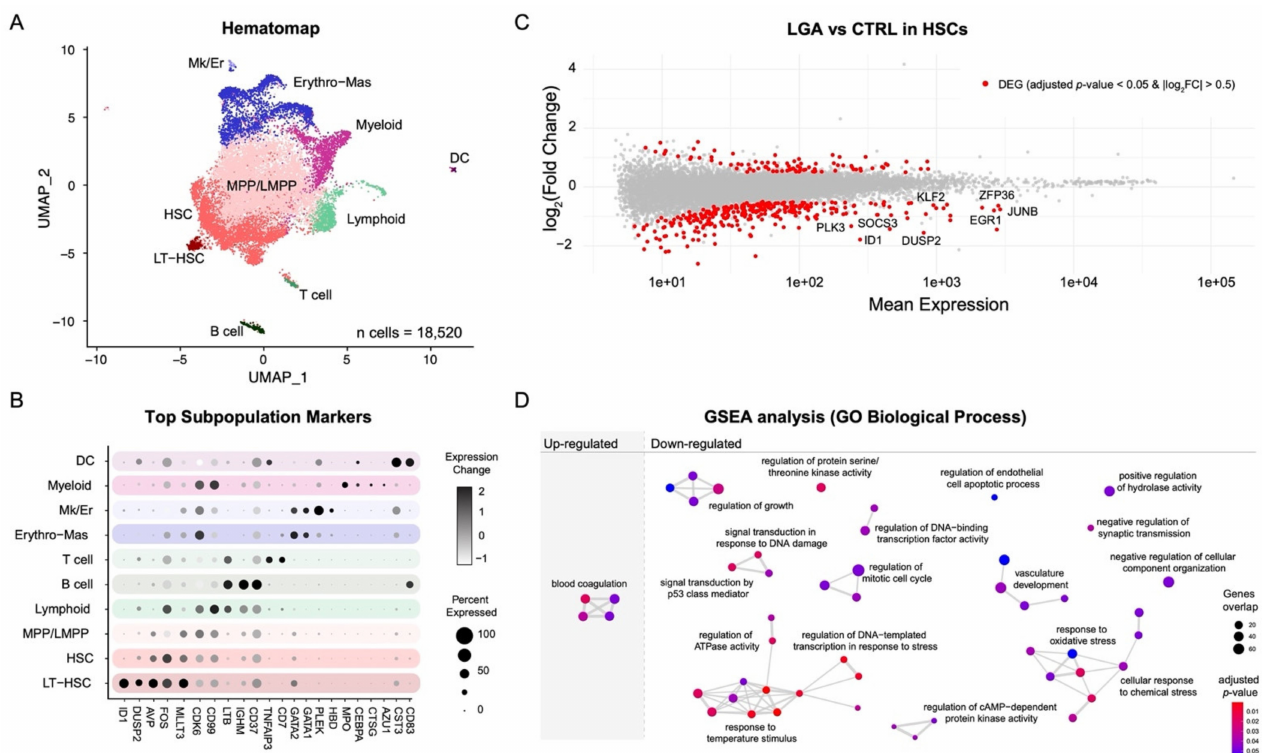
Figure 2. Lineage-specific transcriptomic analysis. ( A ) Hematomap, UMAP representation of dis- tinct HSPC lineages. ( B ) Dot plot representing key markers used to annotate cell populations. LT-HSC, long-term hematopoietic stem cell; HSC, hematopoietic stem cell; MPP, multipotent progeni- tor; LMPP, lymphoid-primed multipotent progenitors; Erythro-Mas, erythroid and mast precursor; Mk/Er, megakaryocyte and erythrocyte; DC, dendritic cell. ( C ) MA plots representing gene expres- sion analysis in HSCs comparing LGA vs. CTRL. Differentially expressed genes with adjusted p -value < 0.05 and |log 2 FC| > 0.5 are shown in red. ( D ) Network representation of significantly enriched pathways identified through GO GSEA analysis comparing LGA vs. CTRL. Non-redundant pathway annotations have been used. Edges represent interactions between